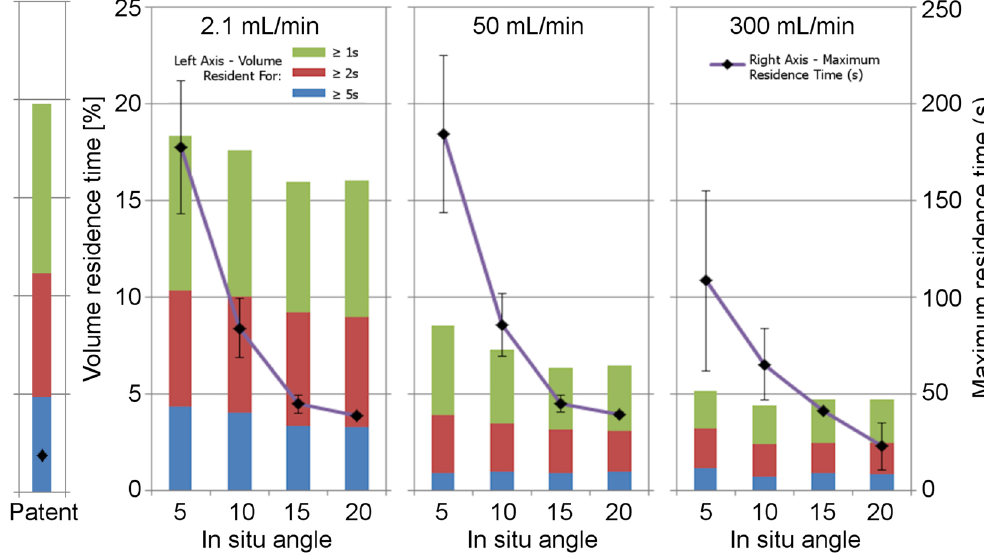
Figure 5. Effect of infusion rate and in situ angle on venous stasis volume and residence time for both catheter sizes combined.